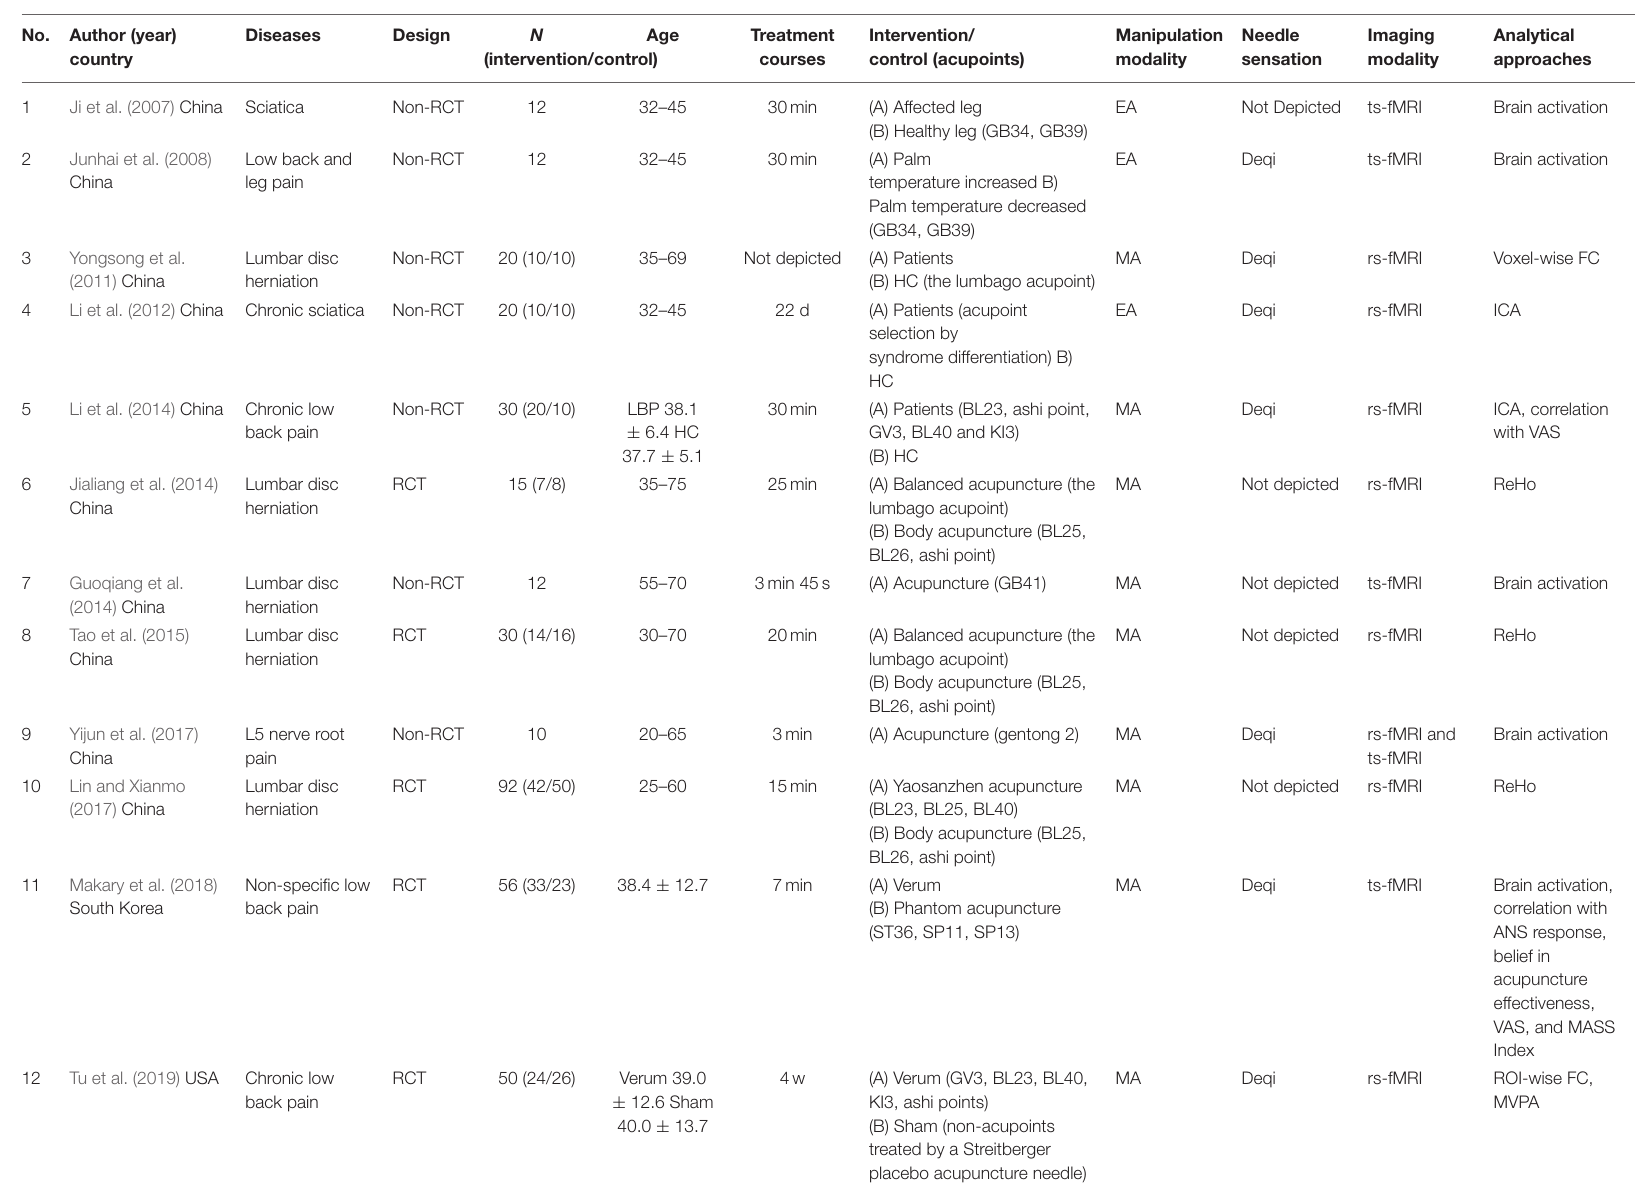
TABLE 1 | Characteristics of the included